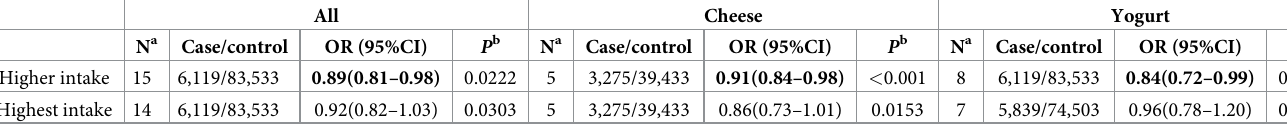
Table 2. Associations between fermented dairy foods and risk of depression. All